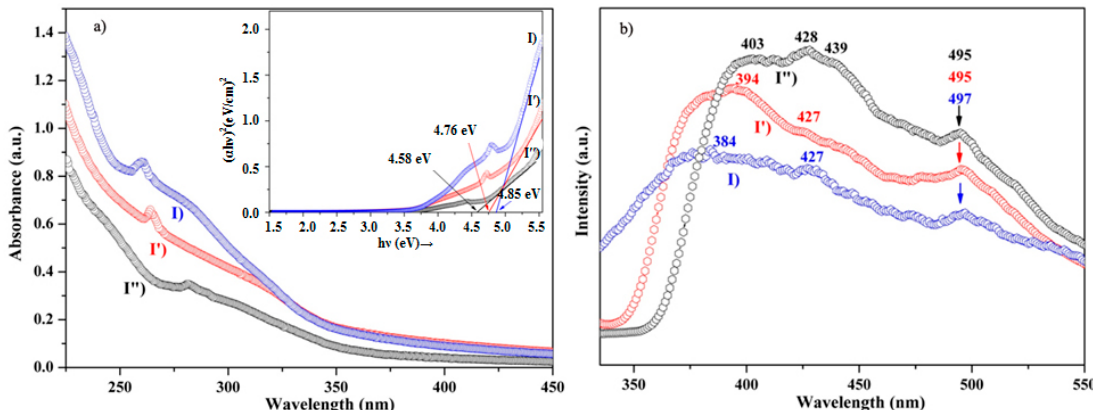
Figure 5. a ) Comparison of Ultraviolet-Visible (UV-Vis) and b ) Photoluminescence (PL) spectra of three samples: Q-ZnS-I (blue symbol scatter), Q-ZnS-I ʹ (red symbol sca tt er), and Q-ZnS-I ʹʹ (black symbol scatter). The inset is the plots of ( α h ν ) 2 versus (h ν ) for three samples: Q-ZnS-I (blue), Q-ZnS-I ʹ (red), and Q-ZnS-I ʹʹ (black). The band gap values were estimated to be 4.85, 4.76, and 4.58 eV for Q-ZnS-I, Q-ZnS-I ʹ , and Q-ZnS-I ʹʹ , respectively.